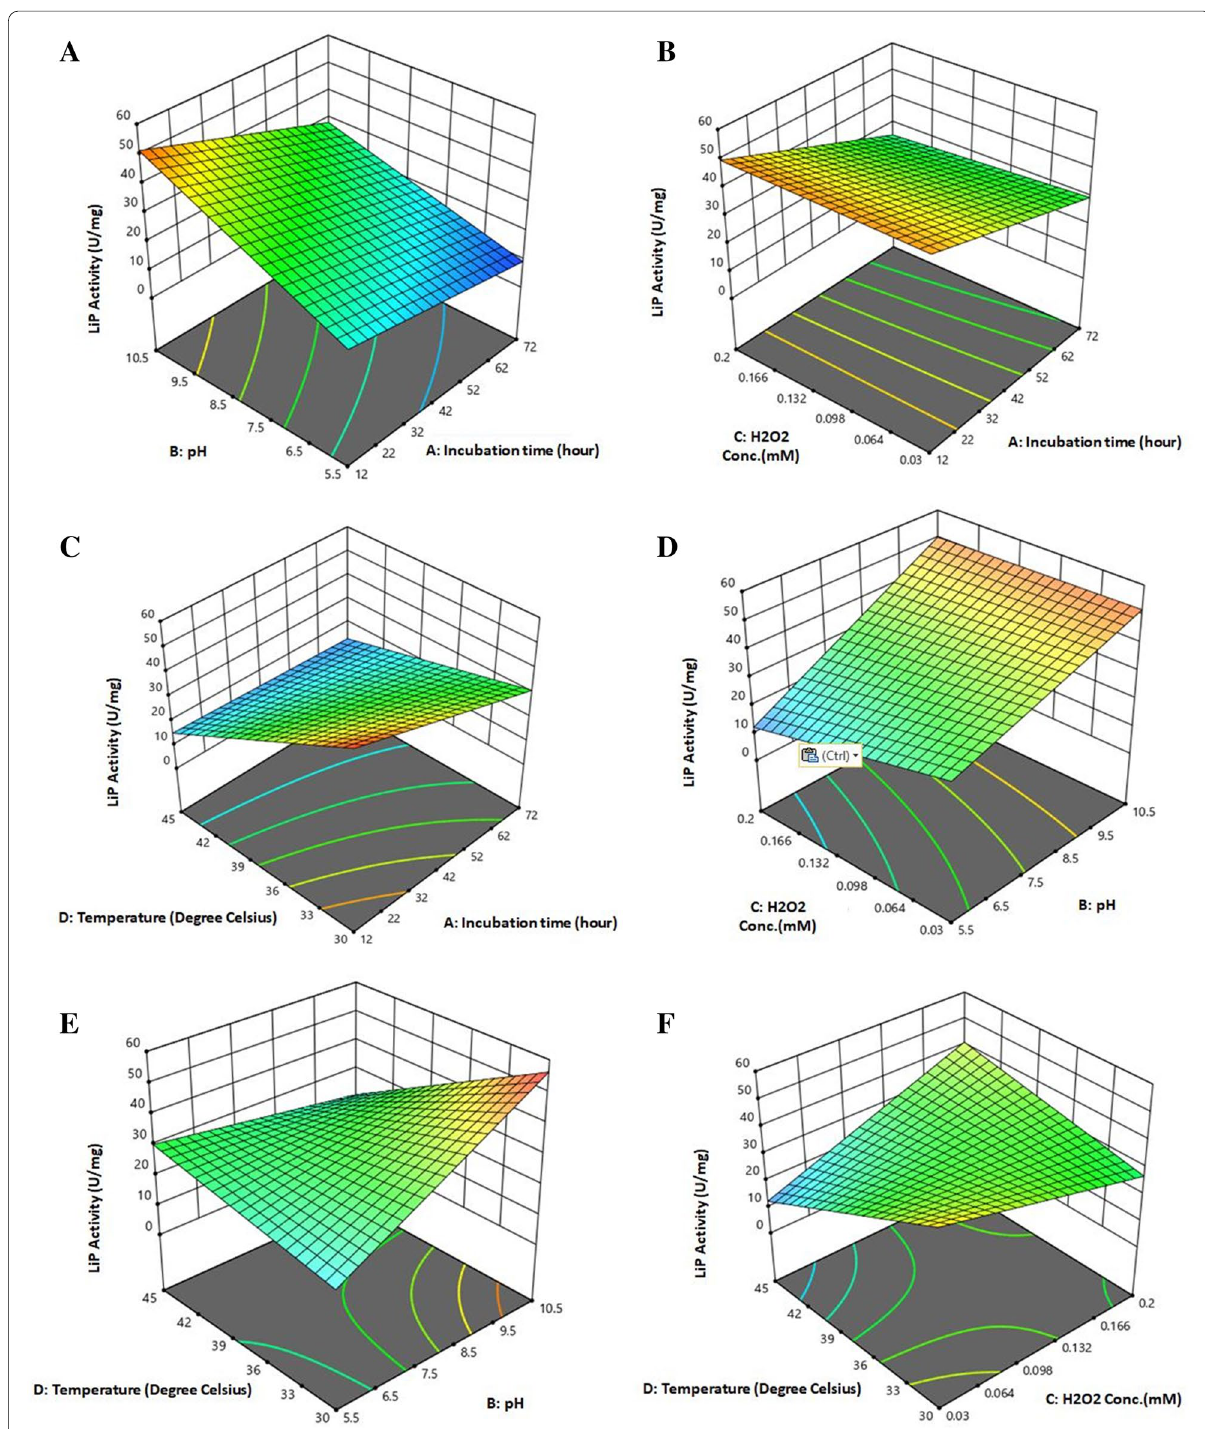
Fig. 8 Response surface graph of LiP activity of the ligninolytic bacterial strain Bacillus mycoides with respect to different experimental factor. a vs. pH, incubation time; b vs. substrate concentration, incubation time; c vs. temperature, Incubation time; d vs. substrate conc., pH; e vs. temperature, incubation time; f vs. temperature, substrate